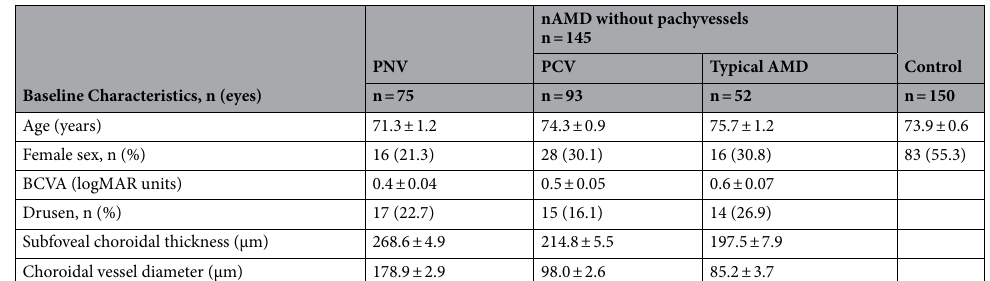
Table 1. Demographic of patients with pachychoroid neovasculopathy (PNV), polypoidal choroidal vasculopathy (PCV), typical age-related macular degeneration (typical AMD), and control. PNV, pachychoroid neovasculopathy; PCV, polypoidal choroidal vasculopathy; nAMD, neovascular age-related macular degeneration; typical AMD, typical age-related macular degeneration; logMAR, logarithm of minimum angle of resolution. Values are means ± standard error of the means. PNV, n = 75; nAMD without pachyvessels, n = 145; PCV, n = 93; typical AMD, n = 52; control, n = 150.